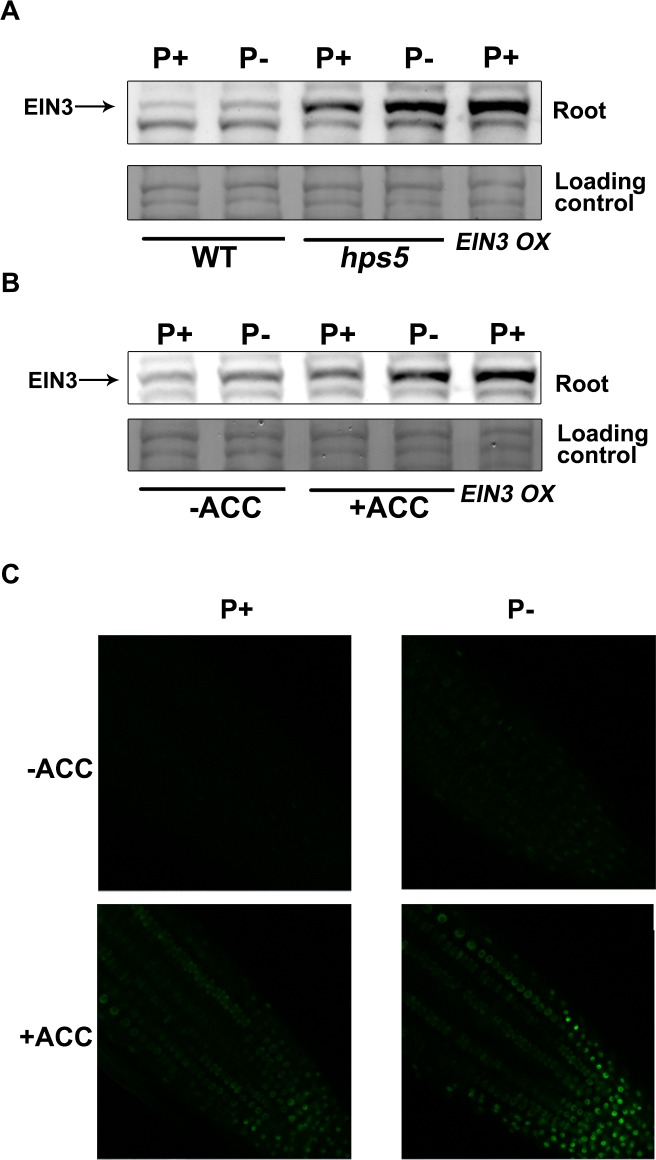
Accumulation of EIN3 protein in WT, hps5, and ACC-treated seedlings grown under P+ and P- conditions.(A) Western blot analysis of EIN3 proteins in WT and hps5 seedlings. (B) Western blot analysis of EIN3 proteins in WT plants treated or not treated with 10 μM ACC. In (A) and (B), the antibodies raised against native EIN3 protein were used. The proteins extracted from the seedlings of the EIN3 OX line were used as the positive control of EIN3 protein. (C) Confocal analysis of the accumulation of EIN3-GFP in the root tips of 7-day-old 35S::EIN3-GFP seedlings grown under various conditions.